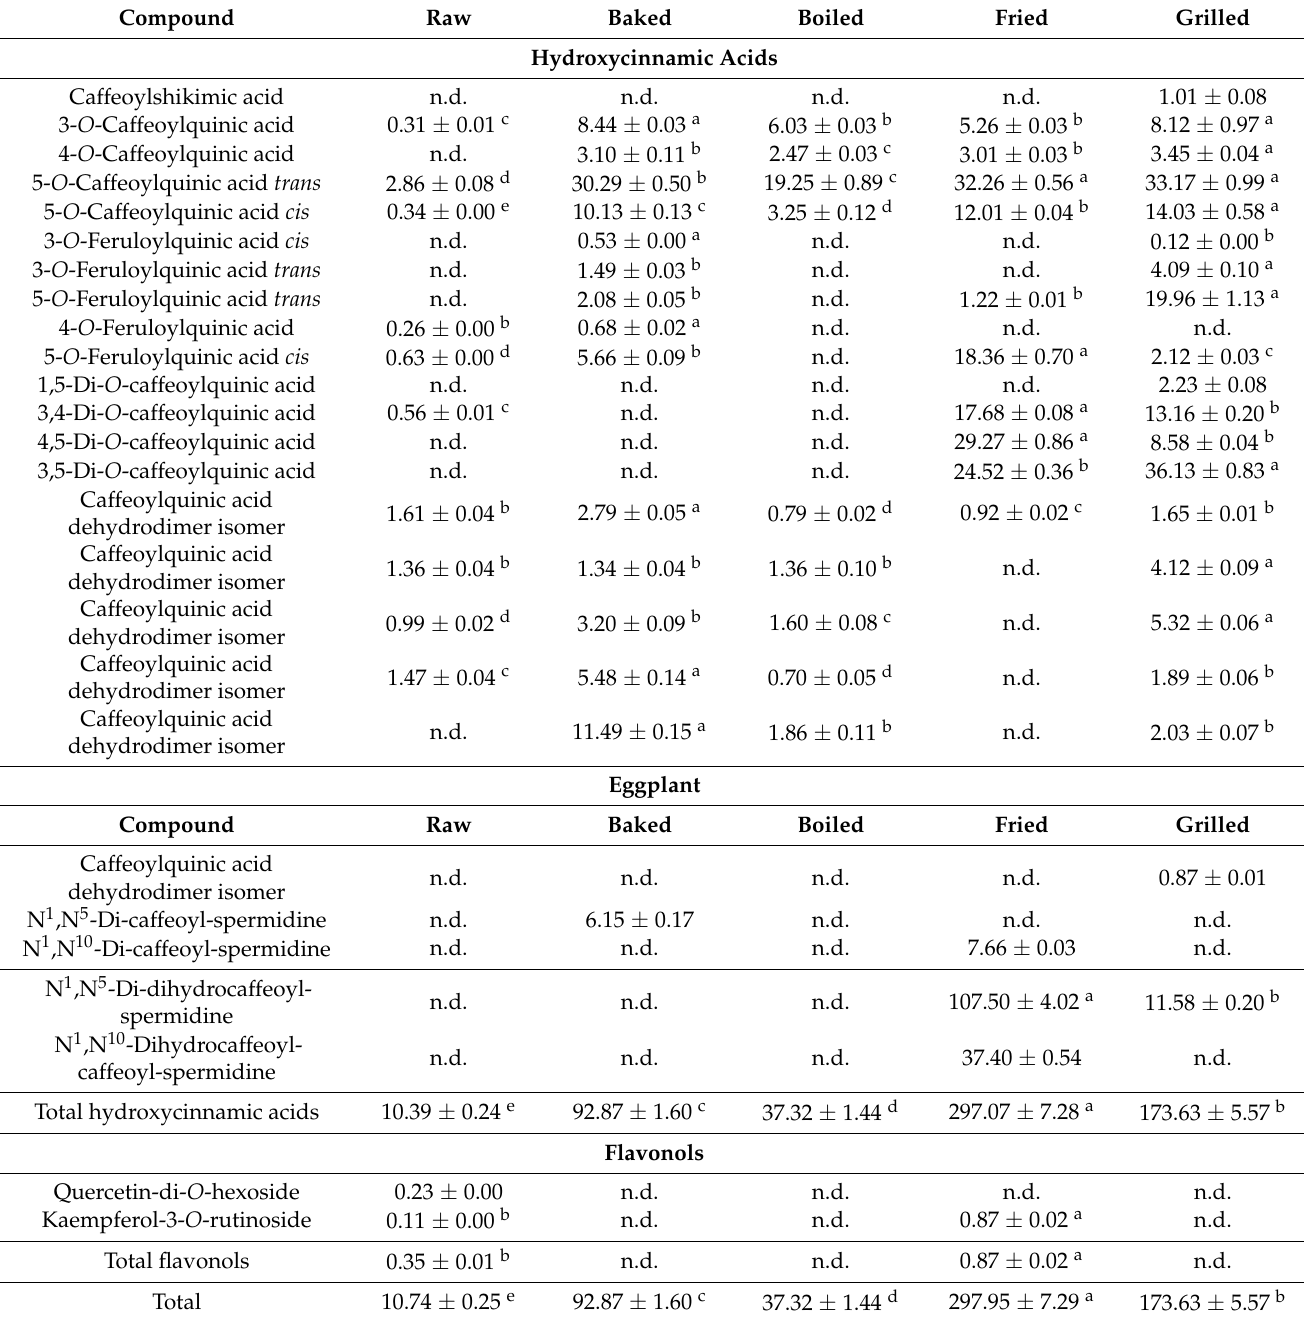
Table 1. Concentration of phenolic compounds in in vitro digested raw and cooked dark purple eggplant phenolic-rich fractions. Results are reported as µ mol of phenolic compounds/100 g of raw or cooked eggplant. In Vitro Digested Dark Purple Eggplant Phenolic-Rich Fractions Compound Raw Baked Boiled Fried Grilled Hydroxycinnamic